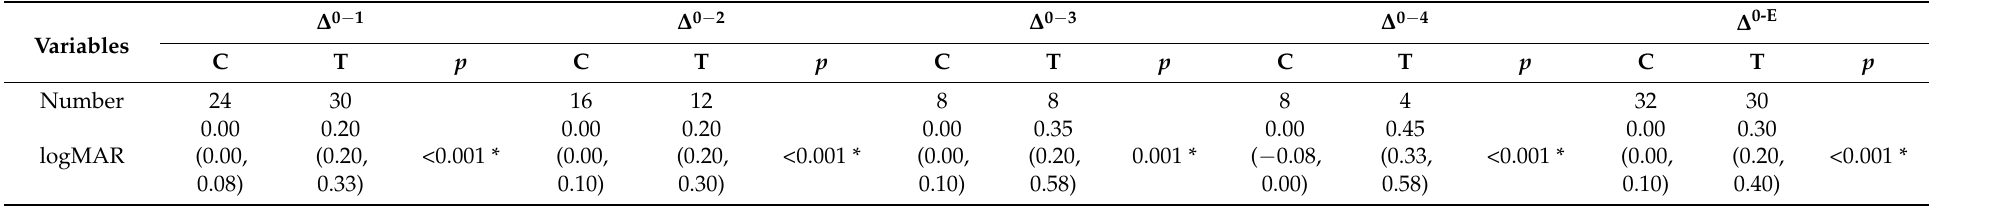
Table 2. Difference between follow-up and baseline among 2 groups.